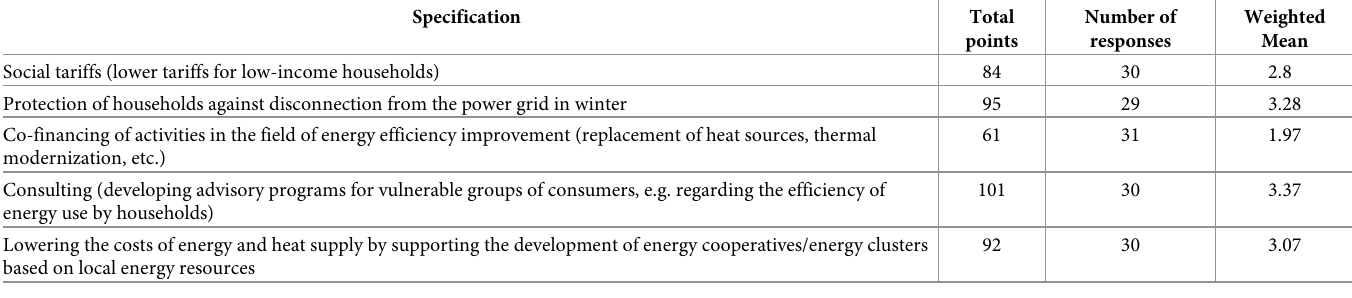
Table 2. Methods of combating energy poverty in rural areas in Poland preferred by the